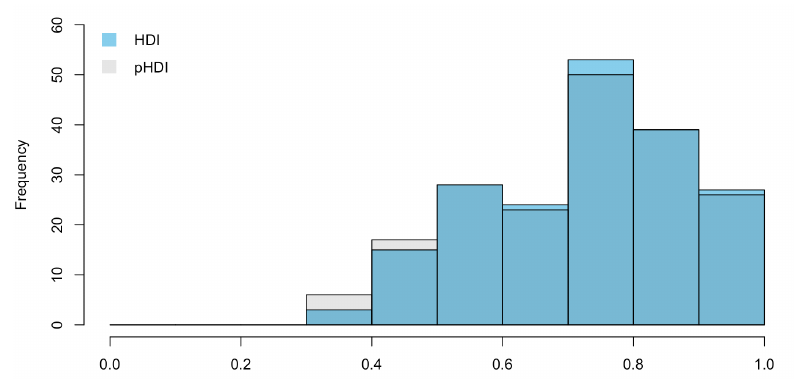
Figure 3. Frequency histogram of HDI and pHDI